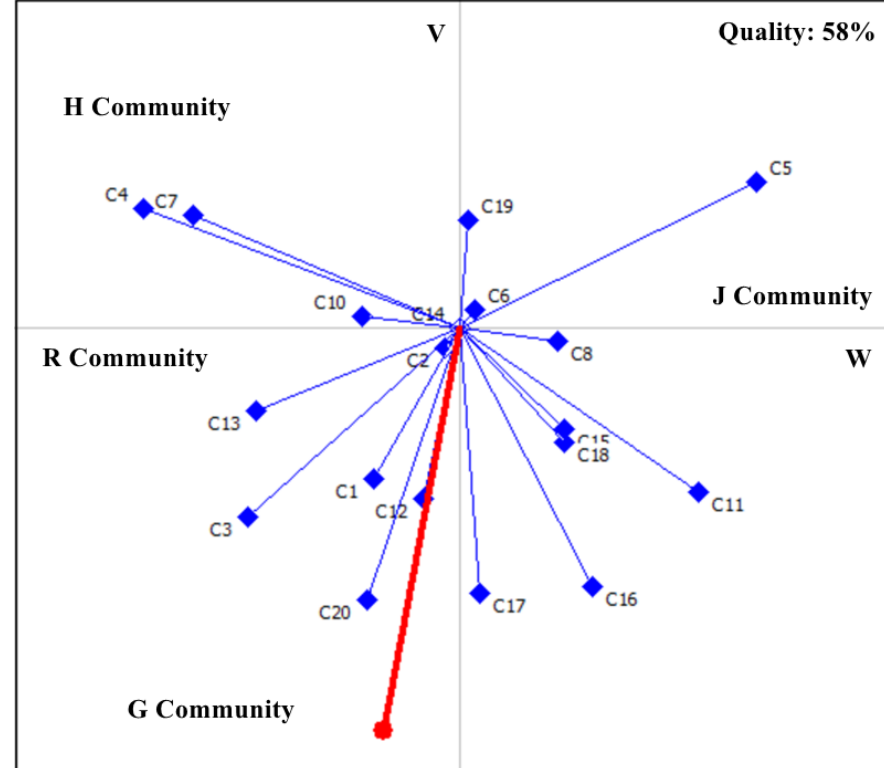
Figure 9. Graphical analysis for interactive aid with V-W coordinate systems. (2) Net traffic ranking analysis of the four communities for assessment results.